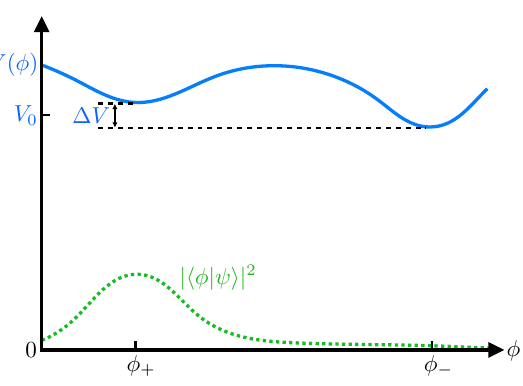
Figure 1 . Potential with a false vacuum (cid:30) , for which (cid:1) V V 0 (solid blue + and true vacuum (cid:30) (cid:28) (cid:0) curve). The state of our system is not an eigenstate of (cid:30) , but rather is characterized by some j i distribution with (cid:12)nite width in the (cid:30) basis. An example low-energy state initialized primarily in the false vacuum is depicted by the dashed green